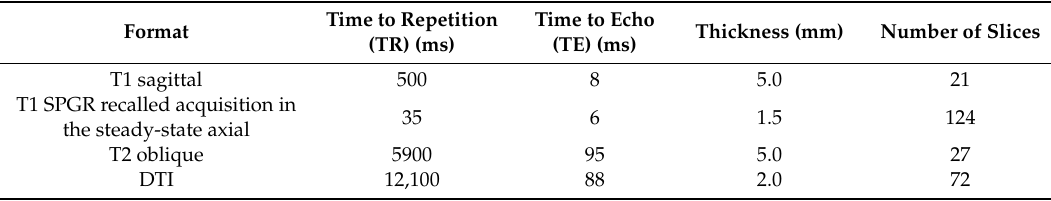
Table 1. Characterization of MRI sequences of the